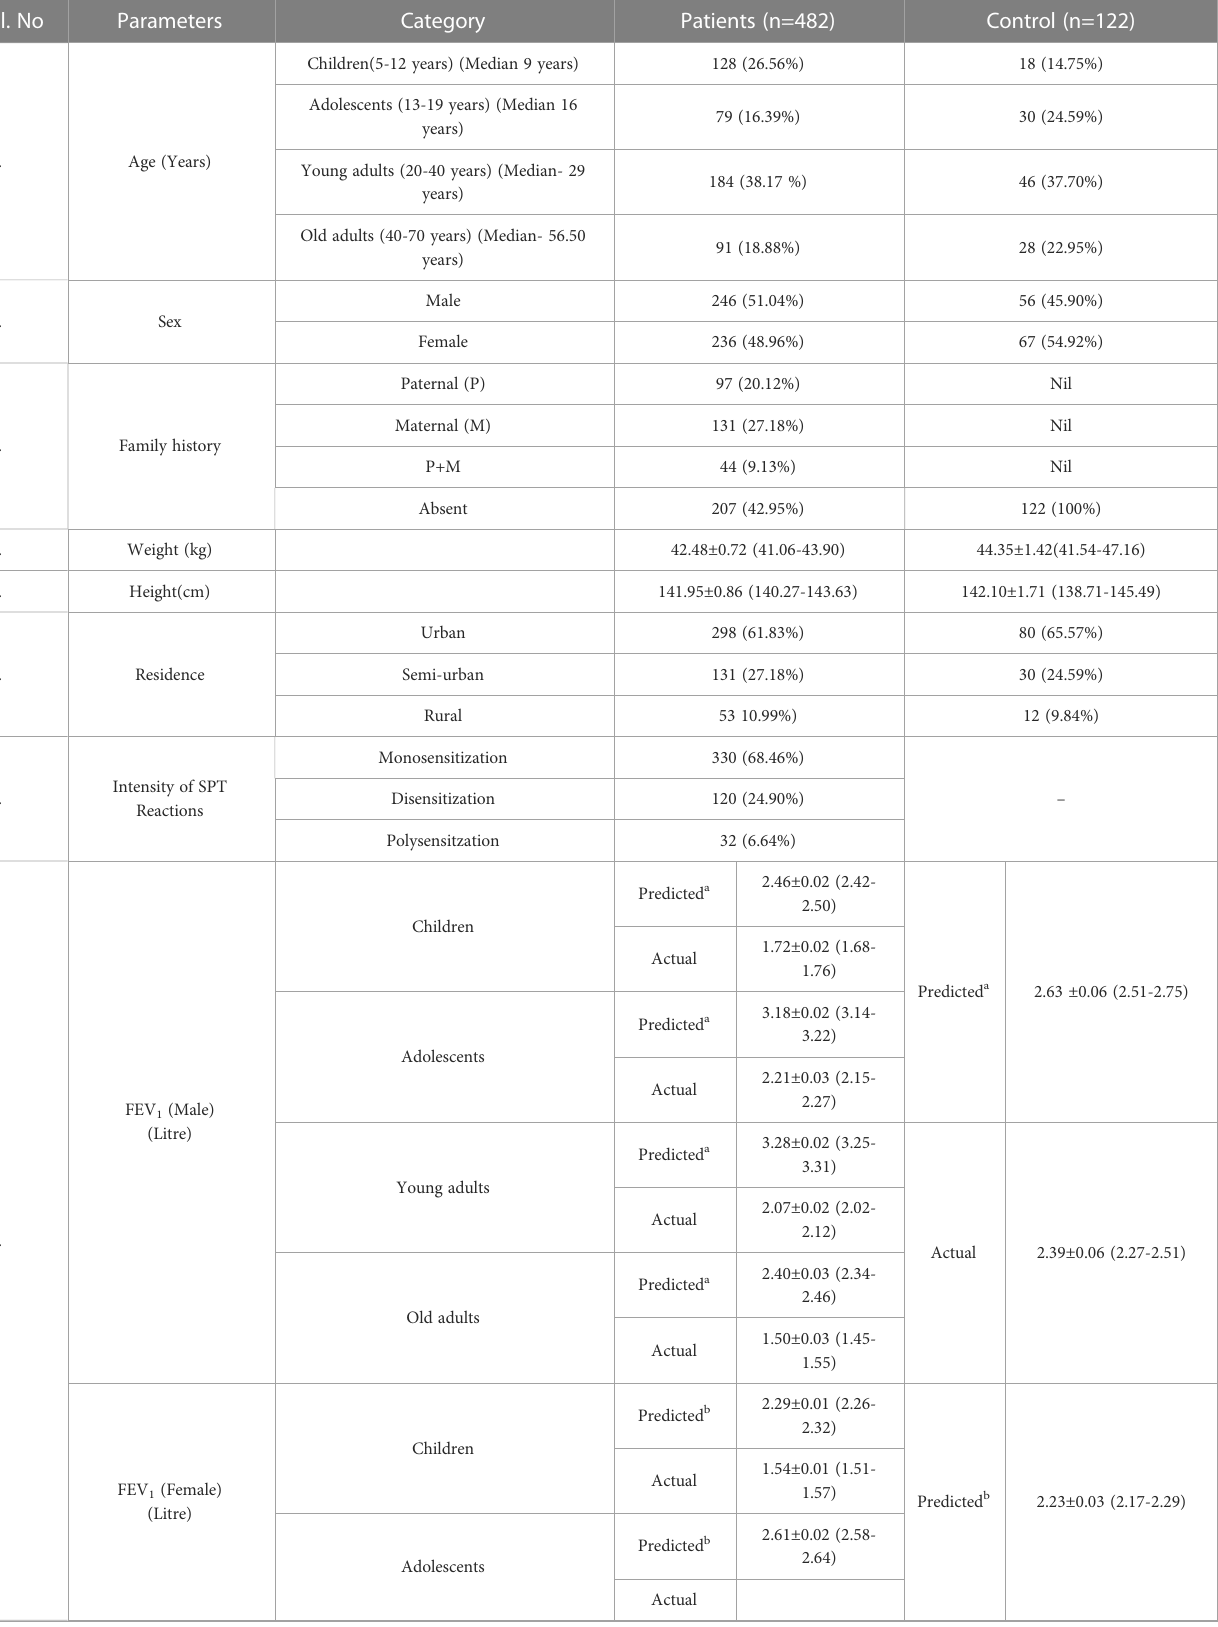
TABLE 2 Demographic and clinical characteristics of patients and control